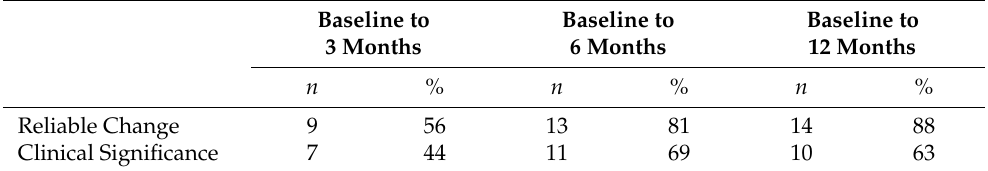
Table 5. Percentage of Participants Achieving Reliable and Clinically Significant Change in PTSD Symptoms (PCL-5), from Baseline to 3 Months, 6 Months, and 12 Months. Baseline to Baseline to Baseline to 3 Months 6 Months 12 Months n % n % n % Reliable Change 9 56 13 81 14 88 Clinical Significance 7 44 11 69 10 63